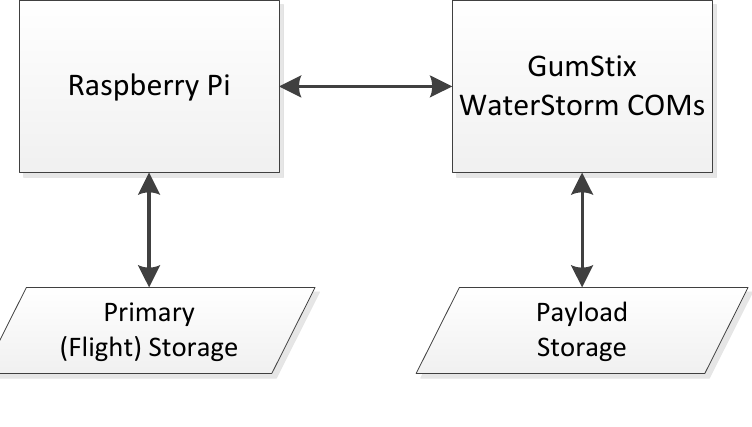
Figure 3. Onboard Processing Separation Between Flight and Payload Processing